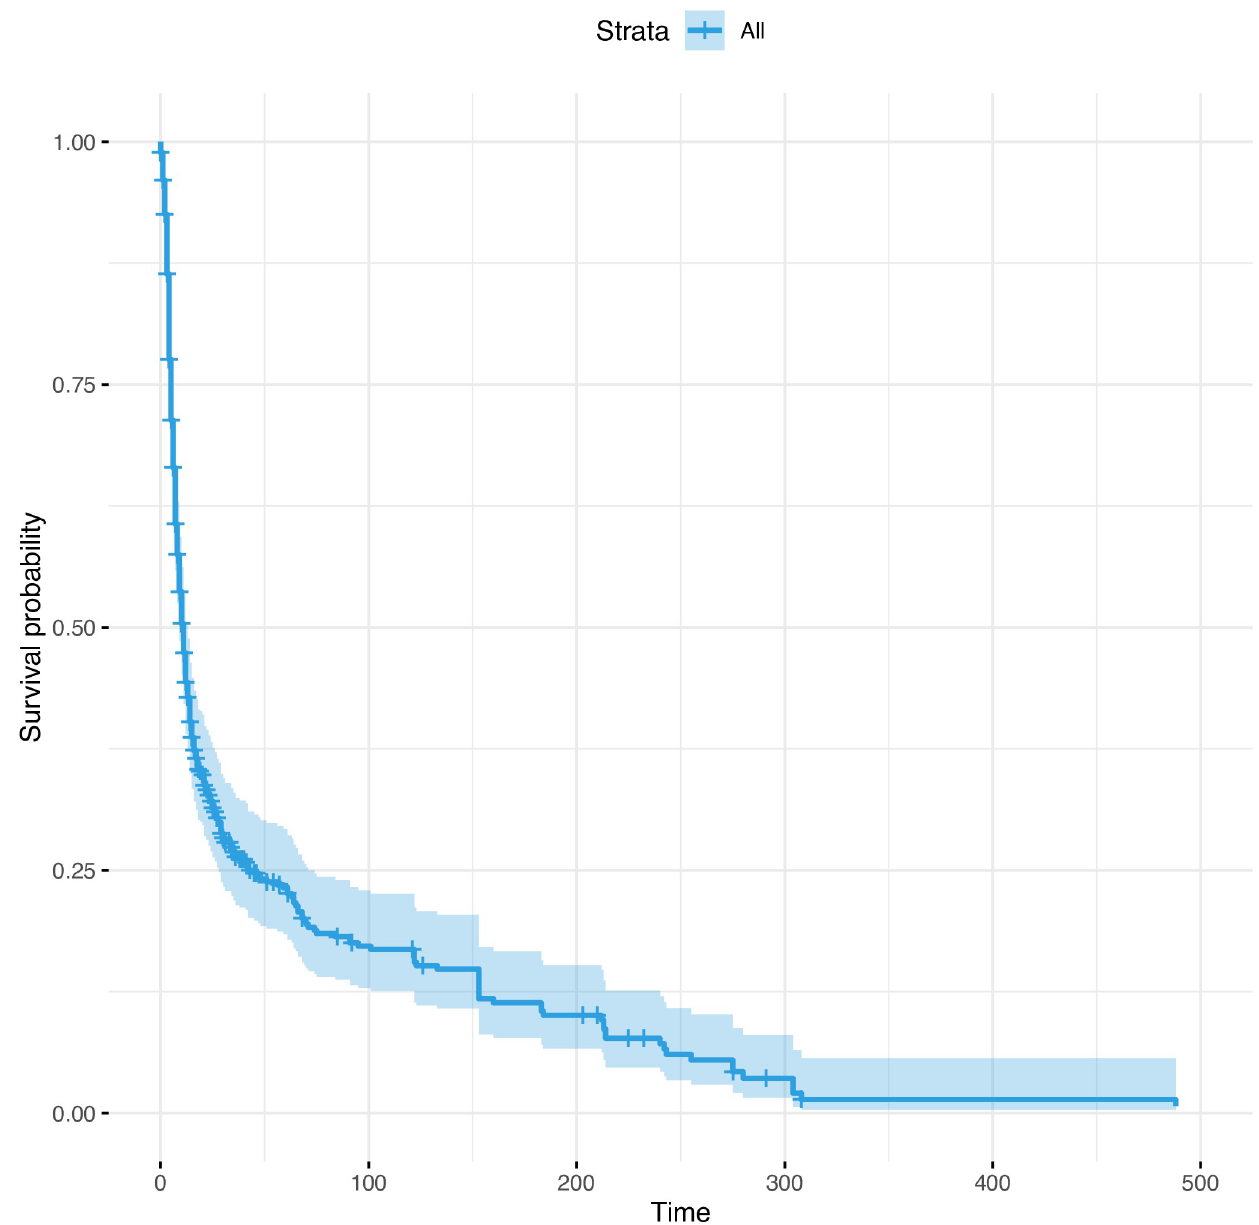
Fig 2. Cox regression predicting the hazard ratio from overweight, asthma, and high white blood